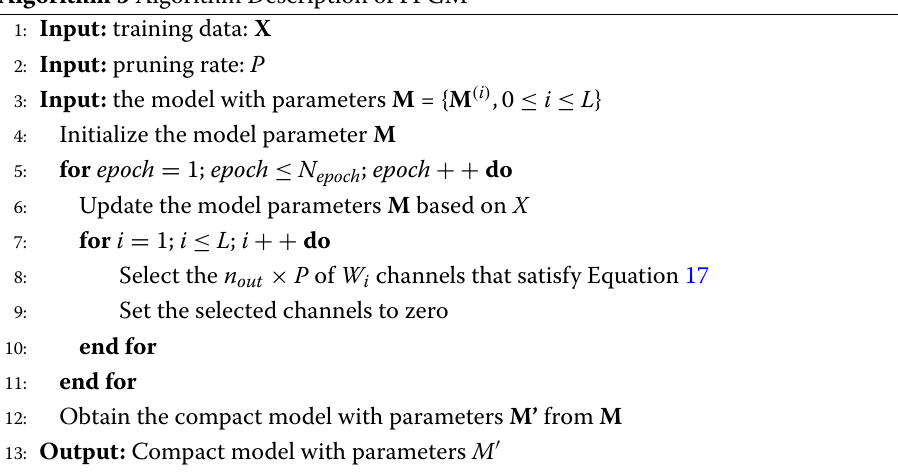
Algorithm 5 Algorithm Description of